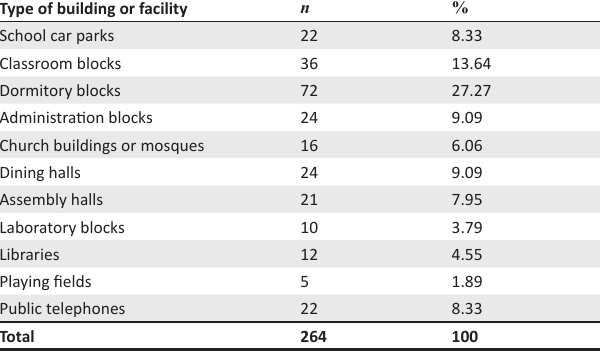
TABLE 4: Type and number of buildings or facilities